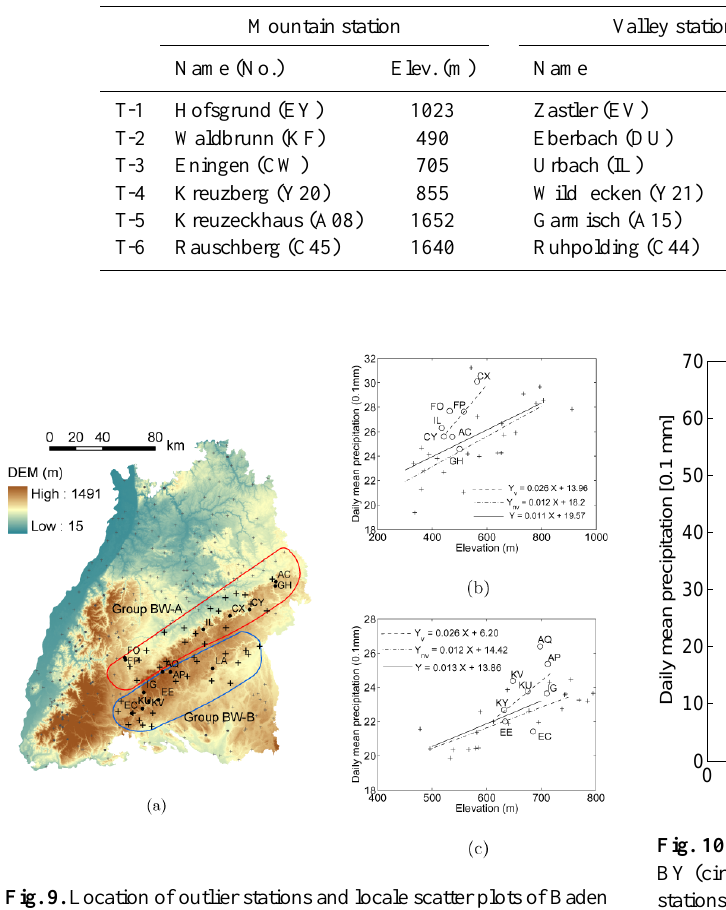
Fig. 9. Location of outlier stations and locale scatter plots of Baden Wuerttemberg (a) . The location of two groups of outliers, Group BW-A and Group BW-B; (b) Scatter plot of Group BW-A; (c) Scat- ter plot of Group BW-B.